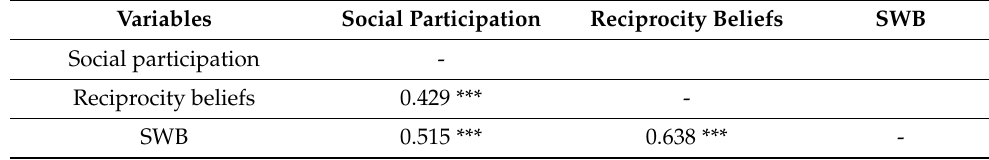
Table 2. Correlations between social participation, reciprocity beliefs, and SWB of older men. Variables